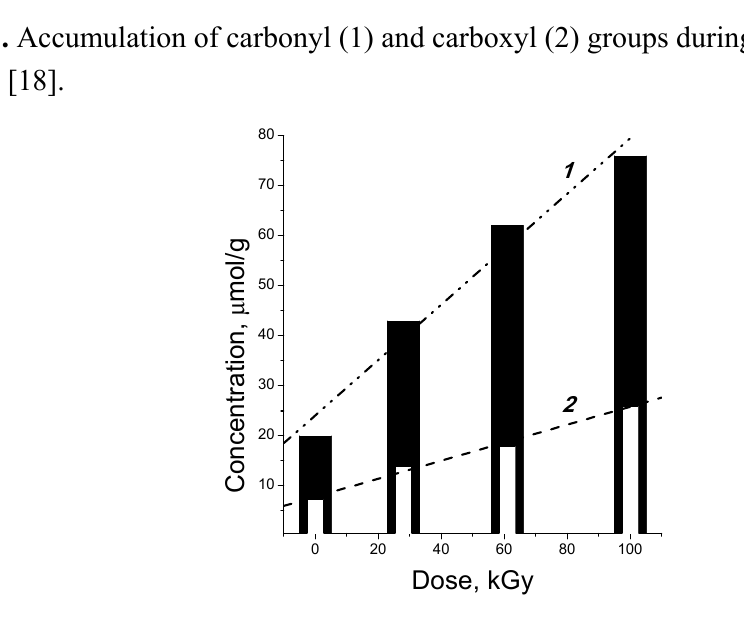
Table 1. Initial concentrations and radiation chemical yields of oxygen-containing groups upon the cellulose γ -radiolysis